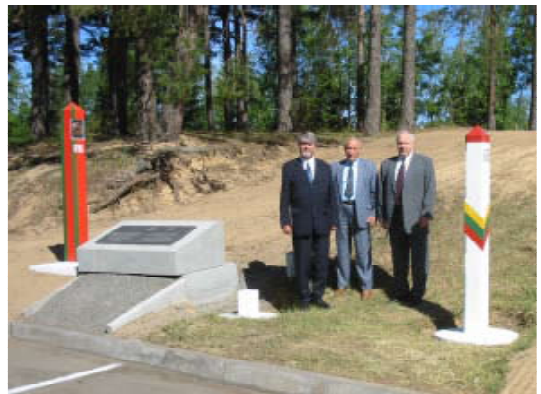
Fig. 5. First state boundary sign installed on